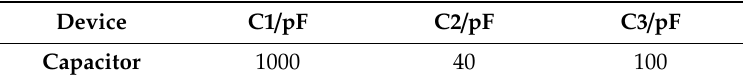
Figure 2. Topology of the high coupled split reactor fault current limiter (HCSR-FCL). Table 1. Parameters of the capacitors.